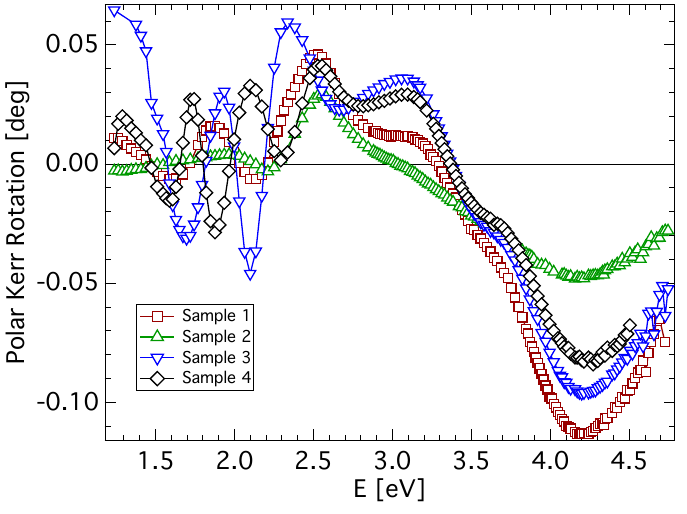
O thin films measured at nearly 2 4